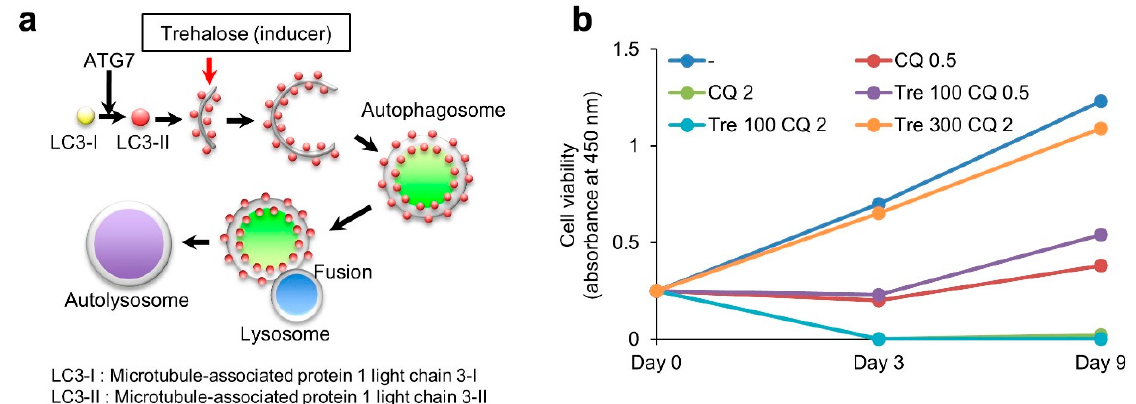
Figure 4. Treatment of KGN cells with trehalose. ( a ) Participation of trehalose (autophagy inducer) in the formation of autophagosome during autophagy. ( b ) Cell viability of KGN cells after chloroquine alone or in combination with trehalose treatment. (-). Untreated. CQ 0.5, chloroquine 0.5 µ M treatment. CQ 2, chloroquine 2 µ M treatment. Tre 100 CQ 0.5, Trehalose 100 µ M + chloroquine 0.5 µ M treatment. Tre 100 CQ 2, Trehalose 100 µ M + chloroquine 2 µ M treatment. Tre 300 CQ 2,